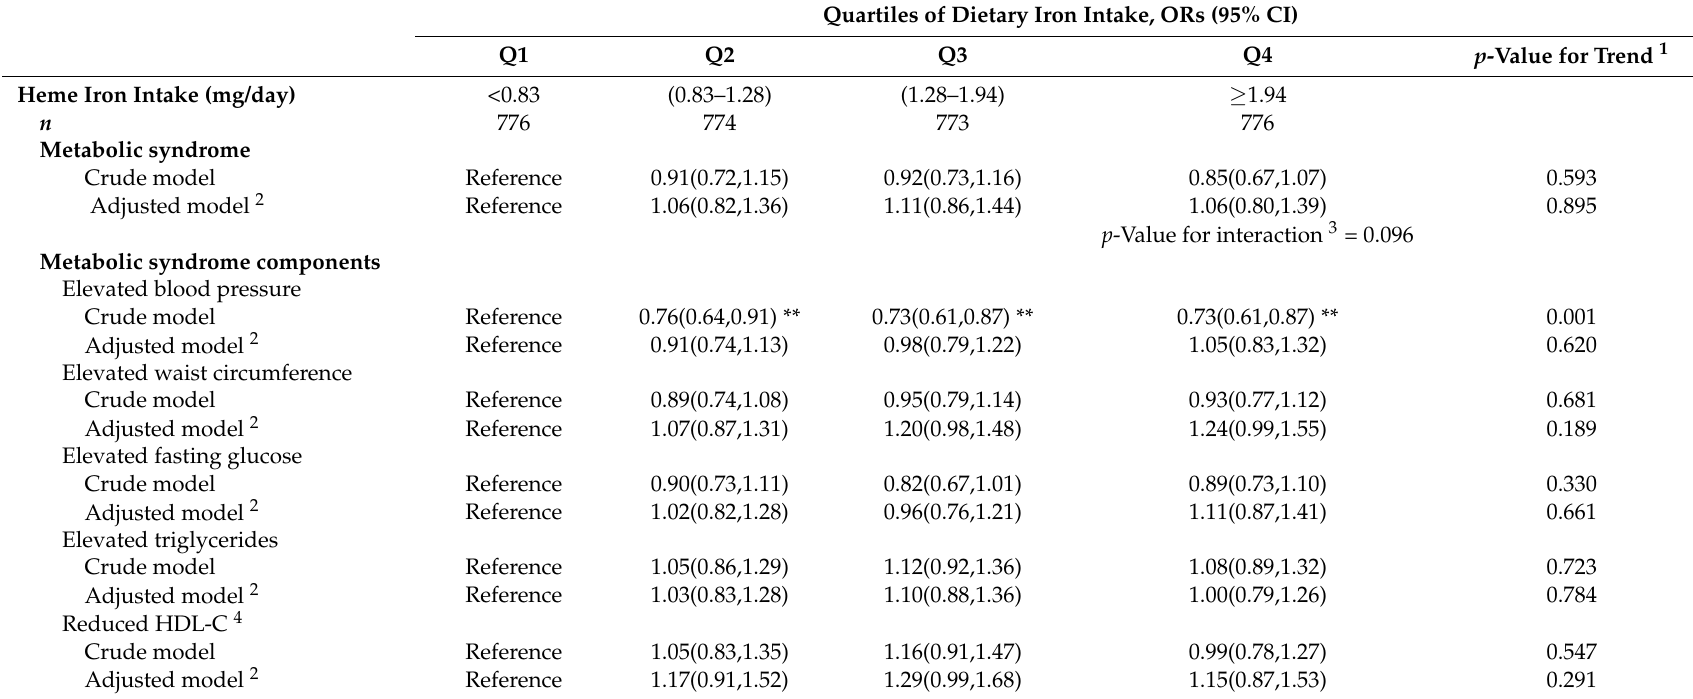
Table 3. ORs (95% CI) for metabolic syndrome and its components according to the quartiles of heme iron intake (mg/day) among all participants in the SDHS